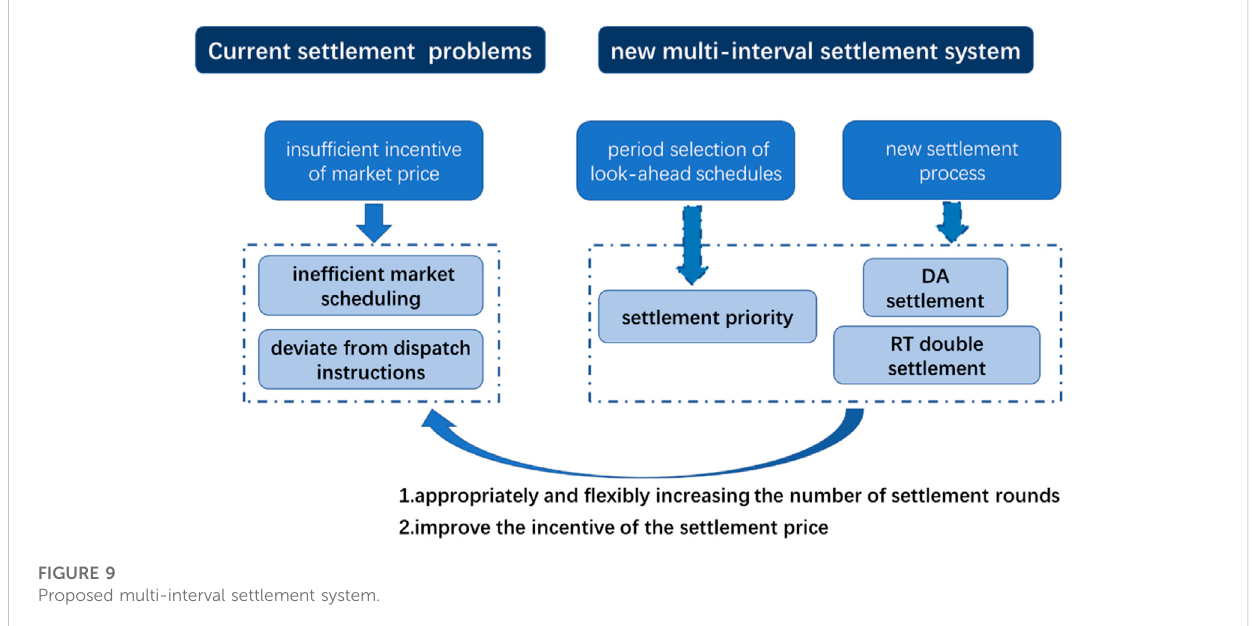
FIGURE 9 Proposed multi-interval settlement system.